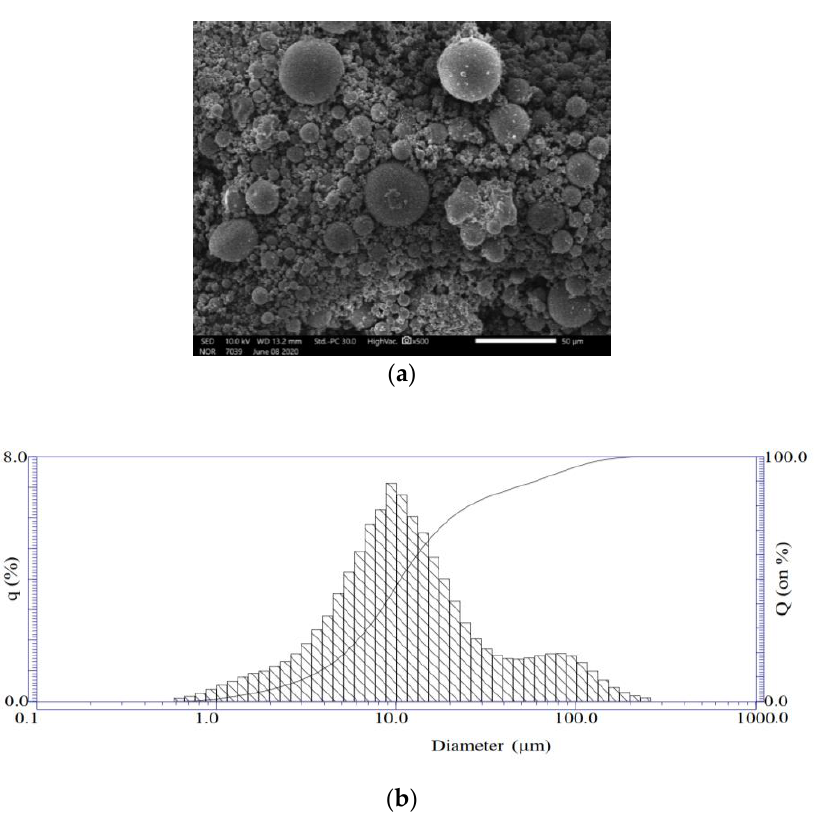
Figure 1. ( a ) SEM of fly ash (FA) particles; ( b ) Size of FA particles varying from 0.6 to 250 µm. Table 1. Chemical composition of FA used.